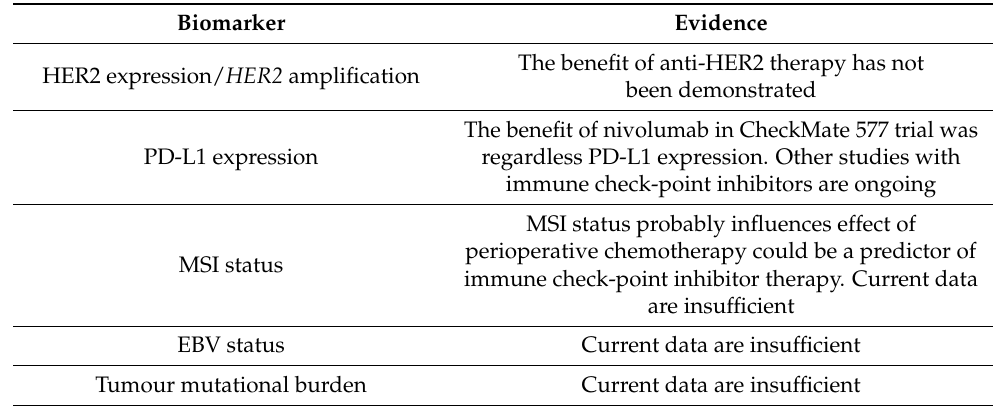
Table 2. The main predictive biomarkers under research in locally advanced oesophageal